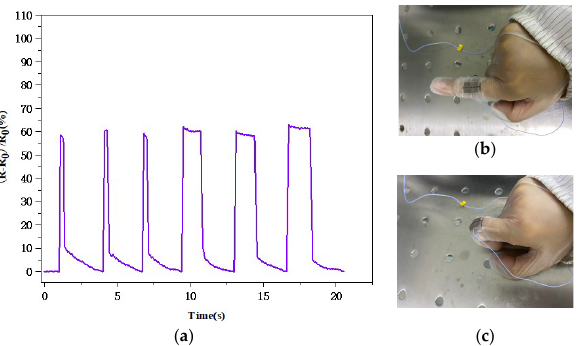
Figure 12. ( a ) Real-time response graph for the flexible pressure sensor attached to the finger joint; ( b ) the finger joint in a straight state; ( c ) the finger joint in a bending state. We also attached the flexible pressure sensor to a human wrist to further test the perception function of the sensor. As shown in Figure 13, the resistance of the flexible pressure sensor did not change when the wrist was not bent. The morphology of the sili- con nanomembrane changed slightly due to bending, which changed its resistance. The relative rate of change in the resistance of the flexible pressure sensor was basically be- tween 30.18 and 32.17% when the wrist was constantly bent, and there was a slight differ- ence each time because the degree of wrist bending was not completely identical, which indicated that the flexible pressure sensor could maintain a relatively stable output. Tiny mechanical strengths and stimuli were accurately recorded by the flexible pressure sensor, and the repetitive and stable waveform also clearly indicated that the sensor effectively identified the bending of wrist joints. These results show that the sensor has great appli- cation potential in the monitoring and recording of human motion, providing novel in- sights for designing wearable devices.